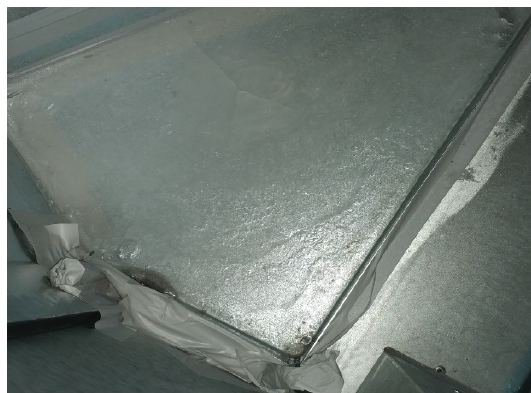
Fig. 8. Iced drip tray at the end of measurements.